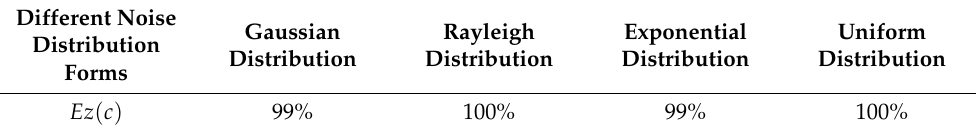
Table 5. Average correct association rate Ez ( c ) of different noise